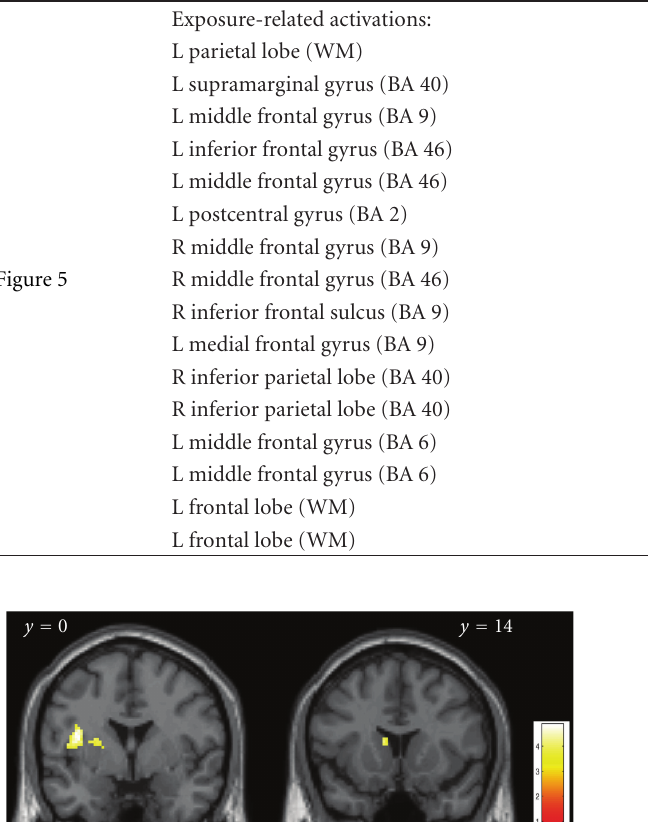
in the six special melodies that would appear five times each throughout phase B. Second, instrument sound in this phase alternated between piano and guitar, in order to help di ff erentiate one melody from the next (the guitar versions of the melodies were not used for the scanning